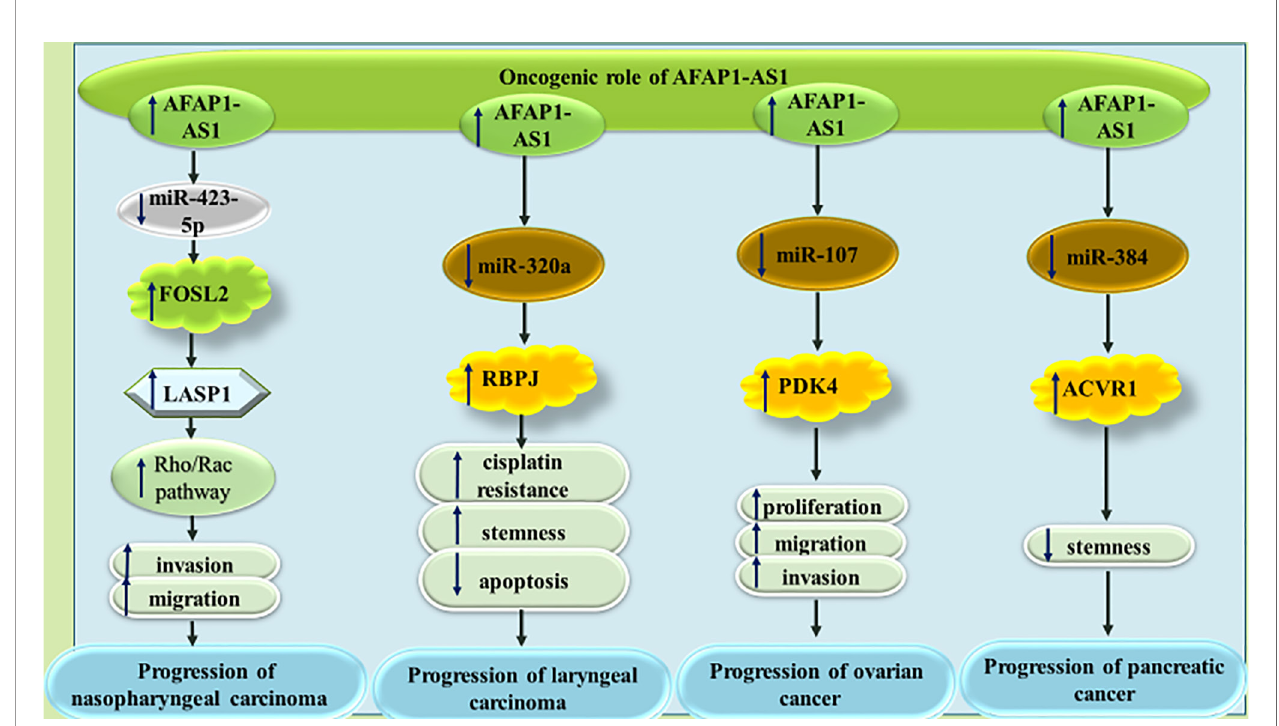
FIGURE 6 | The oncogenic role of AFAP1-AS1 in nasopharyngeal carcinoma, laryngeal carcinoma, ovarian cancer and pancreatic cancer. In all types of mentioned cancers, AFAP1-AS1 can act as molecular sponge for tumor suppressor